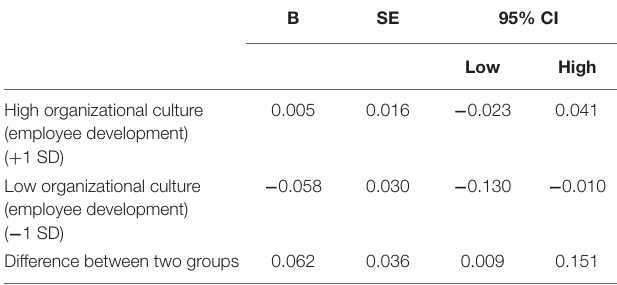
TABLE 5 | Monte Carlo parameter bootstrapping for conditional indirect